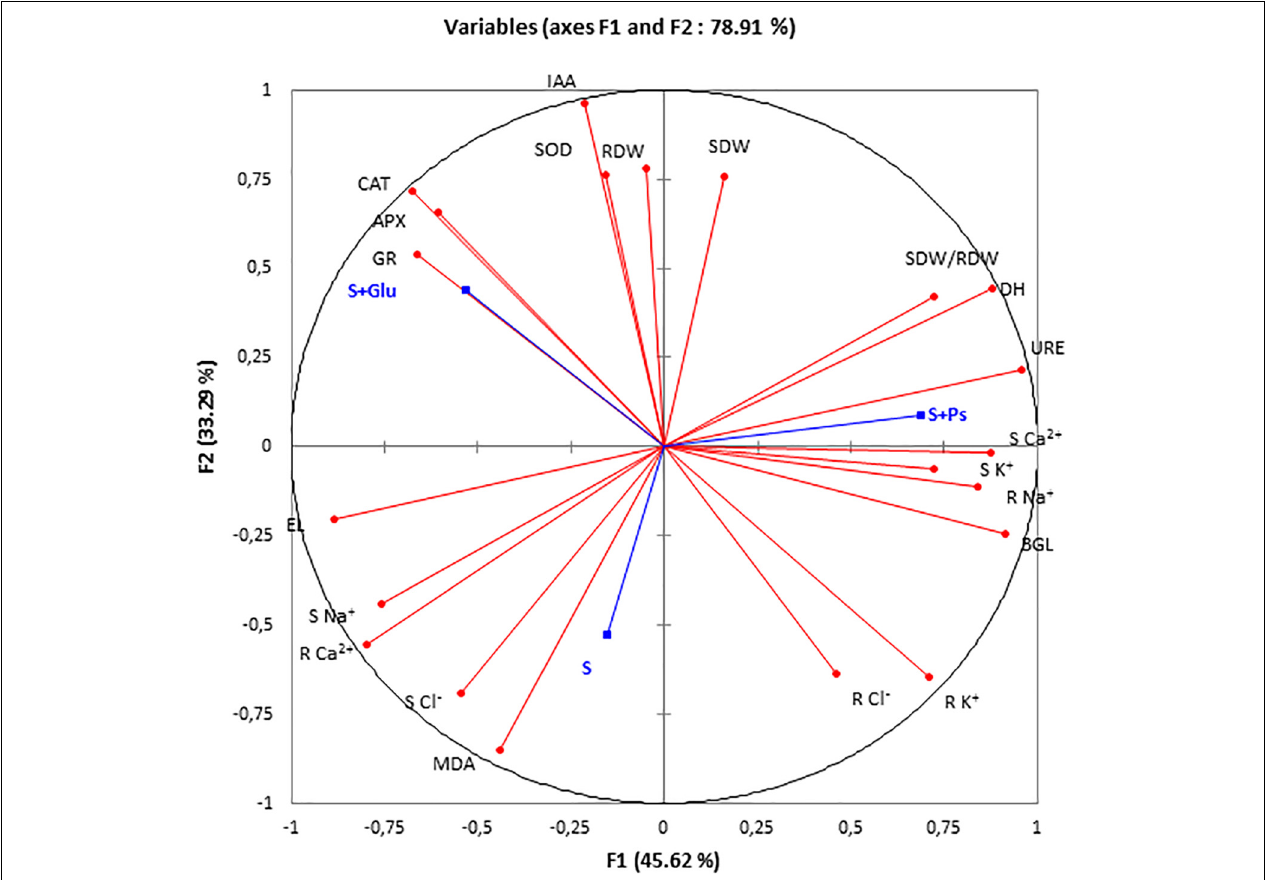
FIGURE 6 | Principal component analysis (PCA). Circles ( • ) represent different analysis parameters. Squares ( (cid:4) ) represent different treatments (S, S + Ps, and S + Glu). All studied parameters and the different treatments are projected onto the F1–F2 principal factorial plane that explains 78.91% of the variation. SDW, shoot dry weight; RDW, root dry weight; SDW/RDW, shoot dry weight/root dry weight ratio; MDA, malondialdehyde; CAT, catalase activity; APX, ascorbate peroxidase activity; SOD, superoxide dismutase activity; GR, glutathione reductase activity; DH, dehydrogenase; URE, urease; BGL, β -glucosidase; IAA, indole-3-acetic acid; S Na + , shoot sodium content; S K + , shoot potassium content; S Ca 2 + , shoot calcium content; S Cl − , shoot chloride content; R findings Na + , root sodium content; R K + , root potassium content; R Ca 2 + , Root calcium content; and R Cl − , root chloride